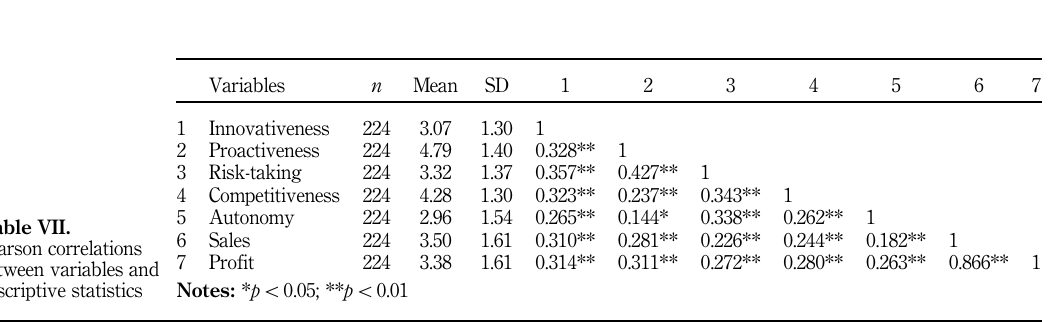
Table VI. Items, Italian translation and reliability coefficients (Cronbach ’ s coefficient α )